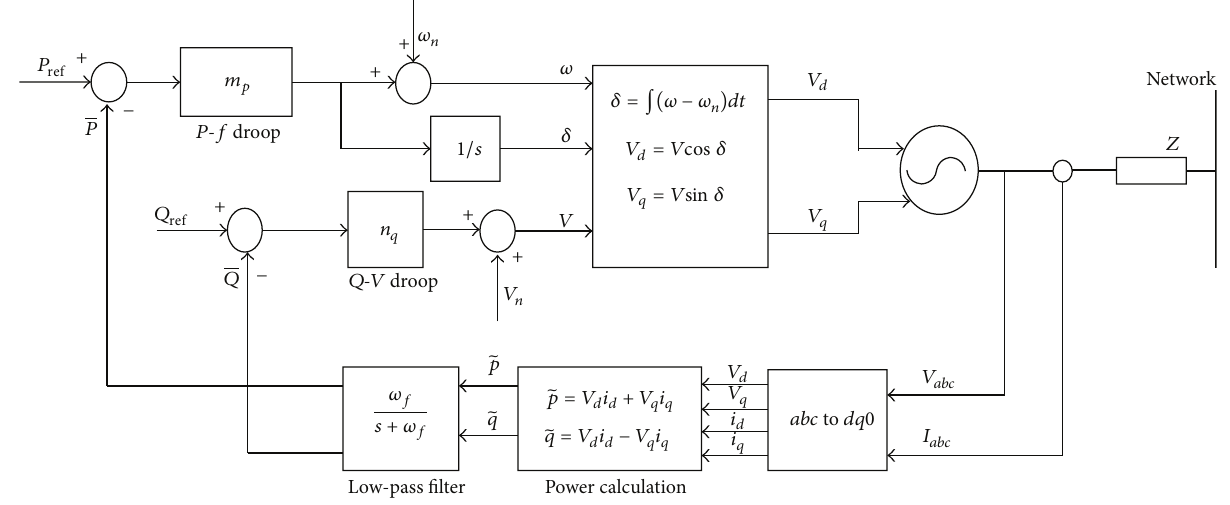
Figure 1: Droop control block